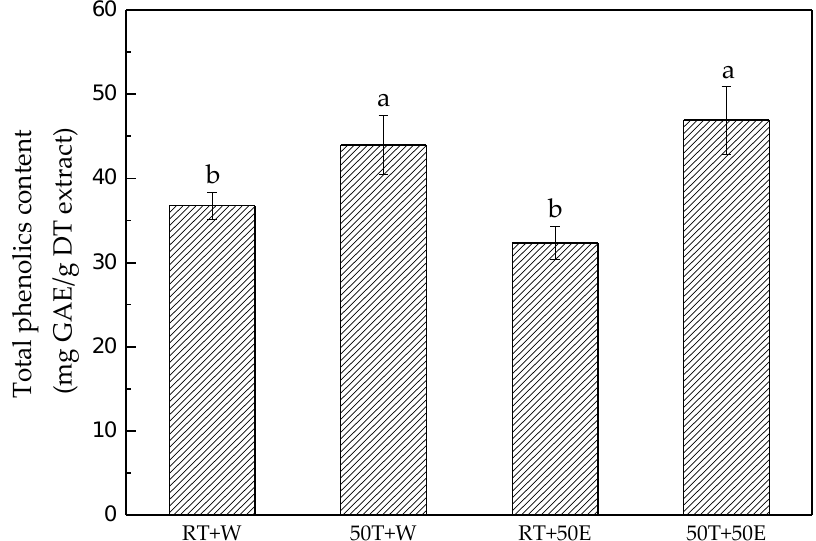
Figure 2. Total phenol content for the four extracts. Treatment means with the same letter are not significantly different.